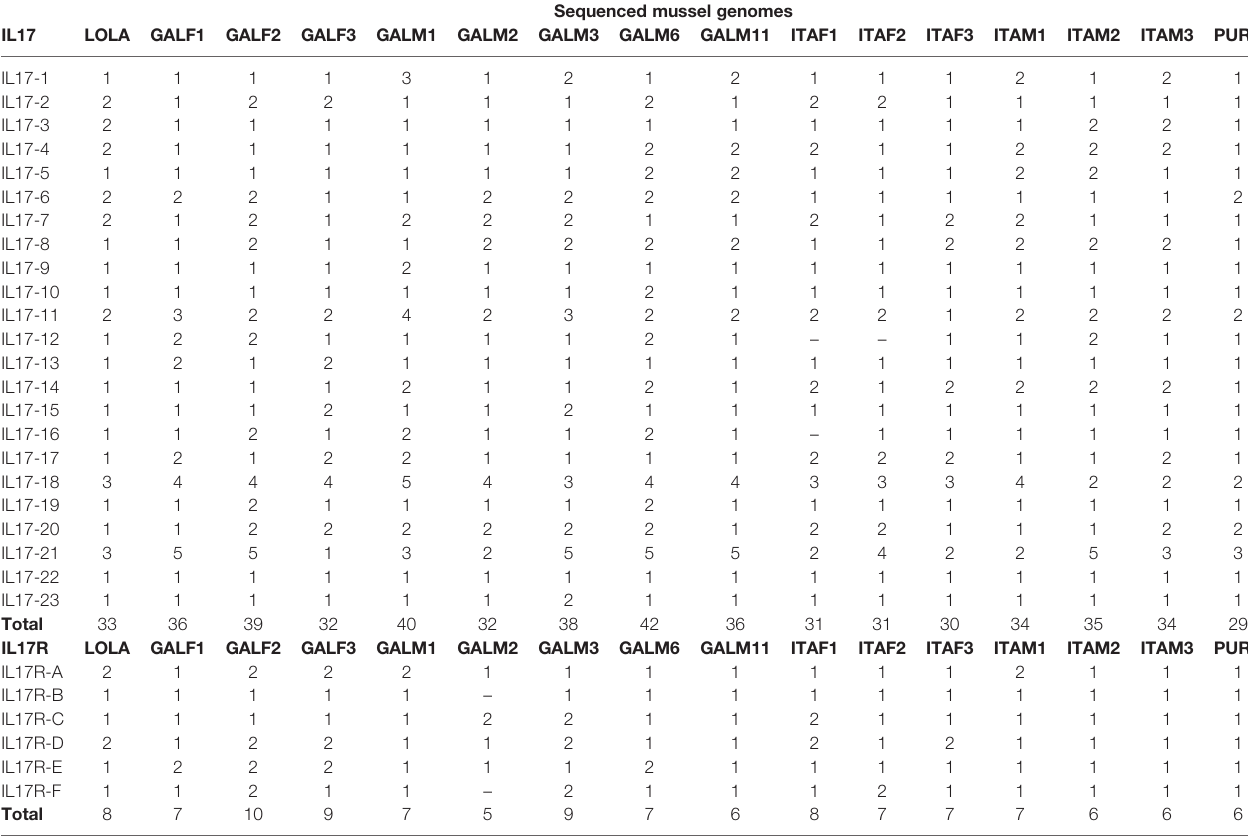
TABLE 1 | Sequences present in each of the 16 analyzed mussel genomes that correspond to the different IL-17 and IL-17R isoforms.